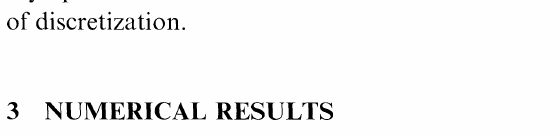
numerical simulations were carried out on a Sparc station 5. The bifurcation diagrams move up and left with m. This is shown in Fig. 1, where we present several bifurcation diagrams of the system (5), with values of m taken as 0.08, 0.05, 0.0287, 0.0. For m > 0 the diagrams are truncated at the first bifur- cation point, only the case m- 0 is shown in